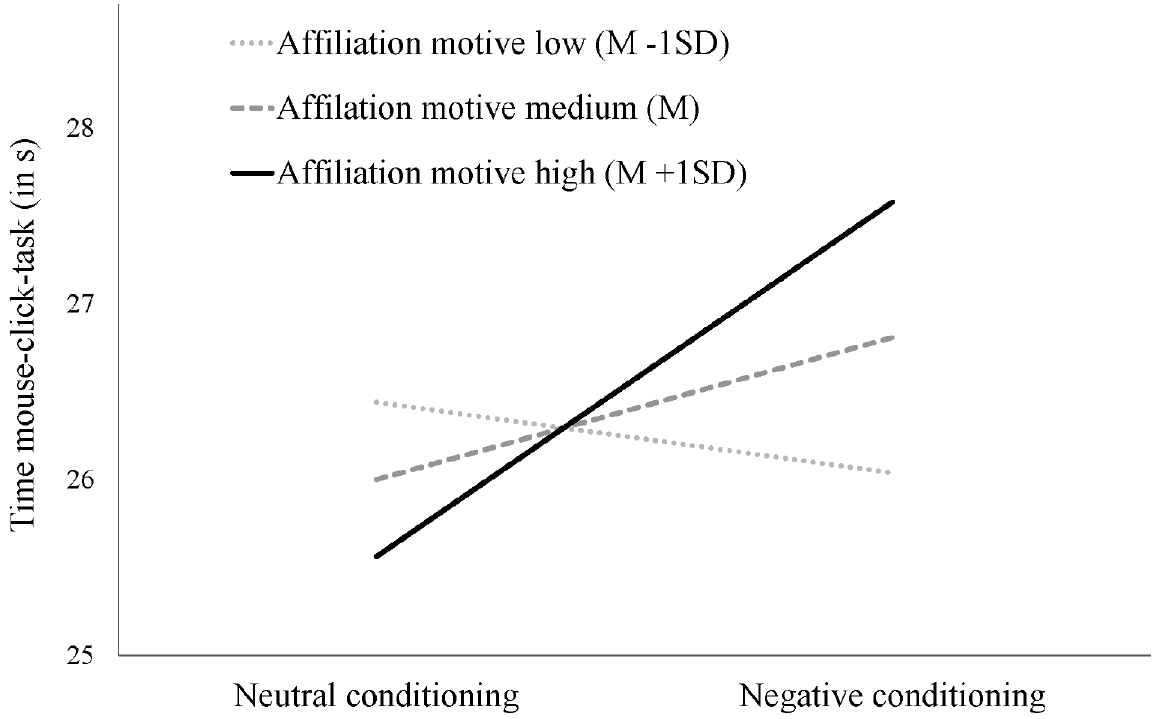
Fig 2. Interaction effects of conditioning and affiliation motive on working times in the mouse-click